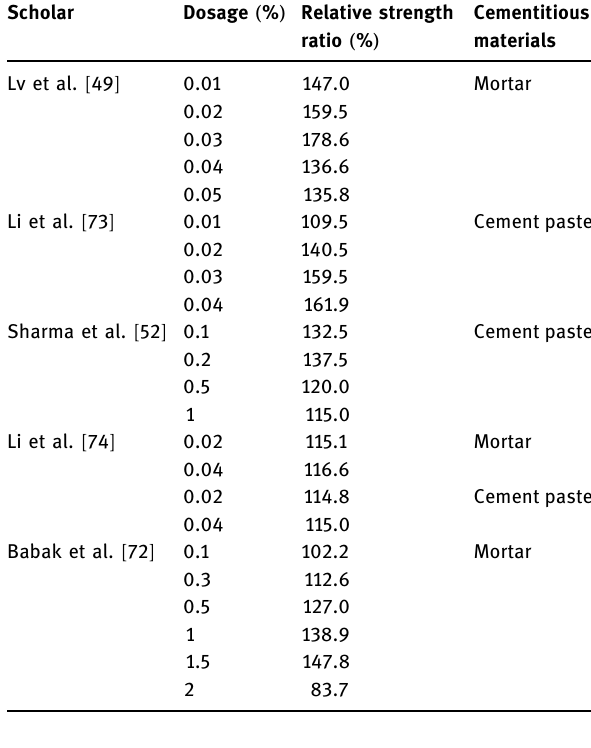
Table 5: Tensile strength of GO - modi fi ed cementitious materials Scholar